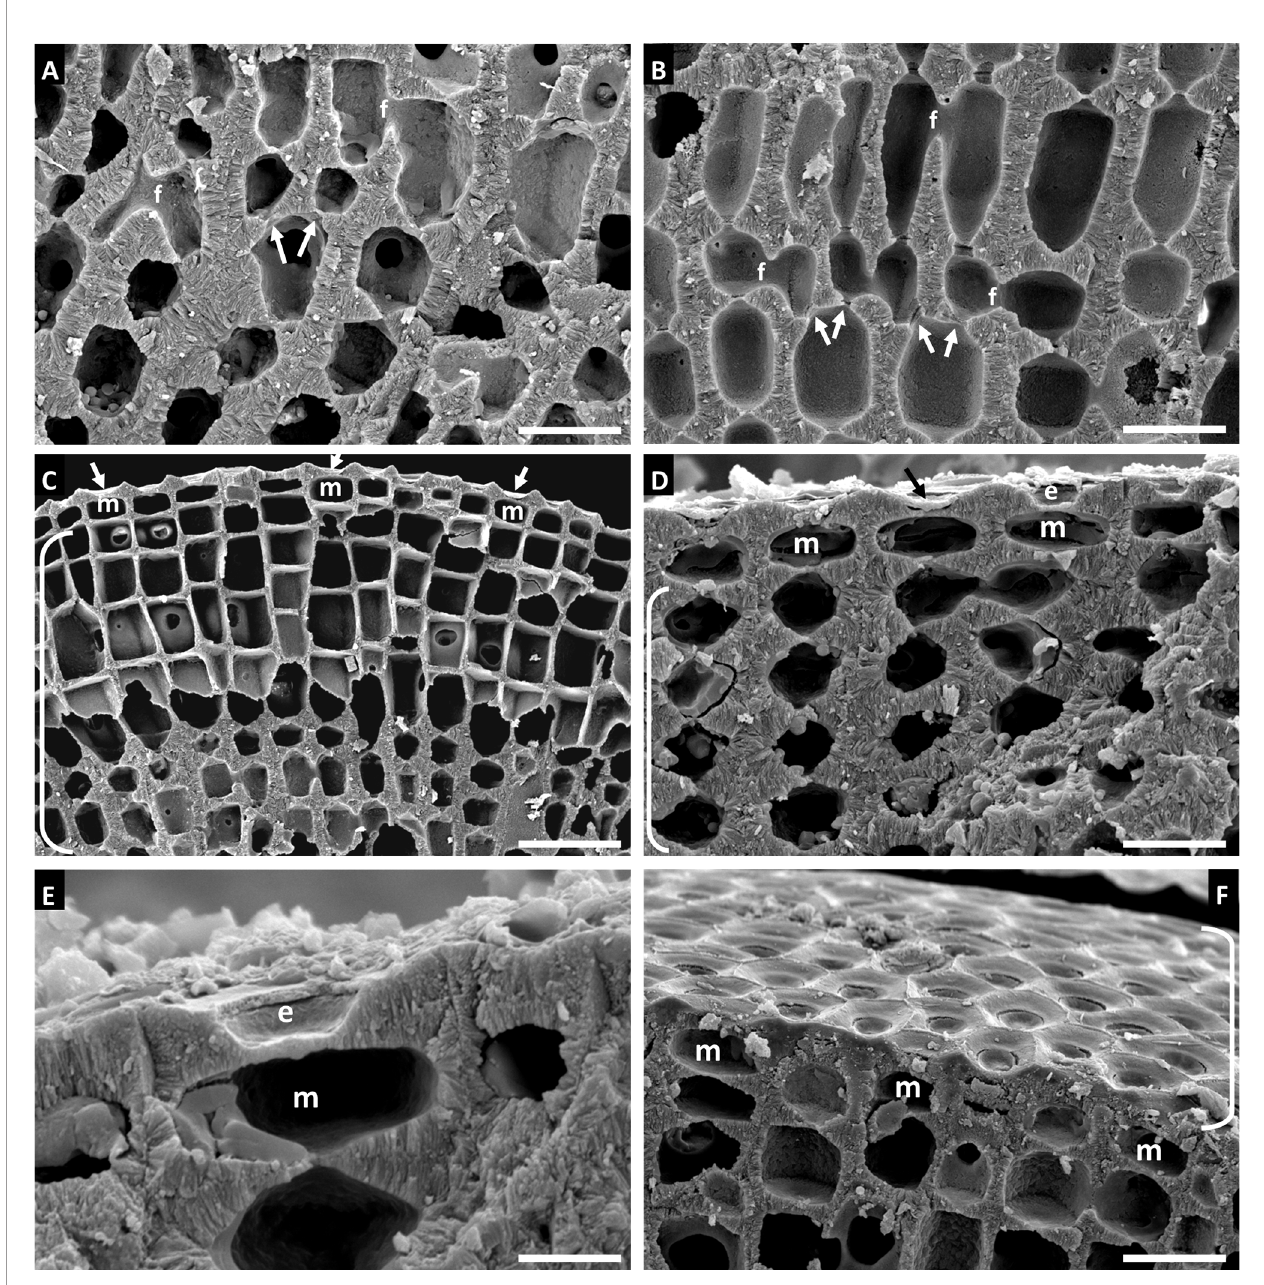
FIGURE 5 | Sporolithon gracile Holotype, voucher no. LAF 7382 (A – F) . (A, B) Perithallus showing locations of pesudodichotomous branching (arrows) and cell fusions (f). Scale bars = 18 µm. (C) Perithallus (bracket), meristematic cells (m), and epithallial cells (arrows). Scale bar = 37 µm. (D) Epithallus showing epithallial cells with roof intact (arrow) and with roof missing (e), intercalary meristematic cells (m), and perithallus (lower bracket). Scale bar = 15 µm. (E) Magni fi ed view of epithallial cell lacking epithallial cell roof (e) and intercalary meristematic cell (m). Scale bar = 5.5 µm. (F) Surface view of epithallial cells (bracket) and partial section view showing intercalary meristematic cells (m). Scale bar = 18